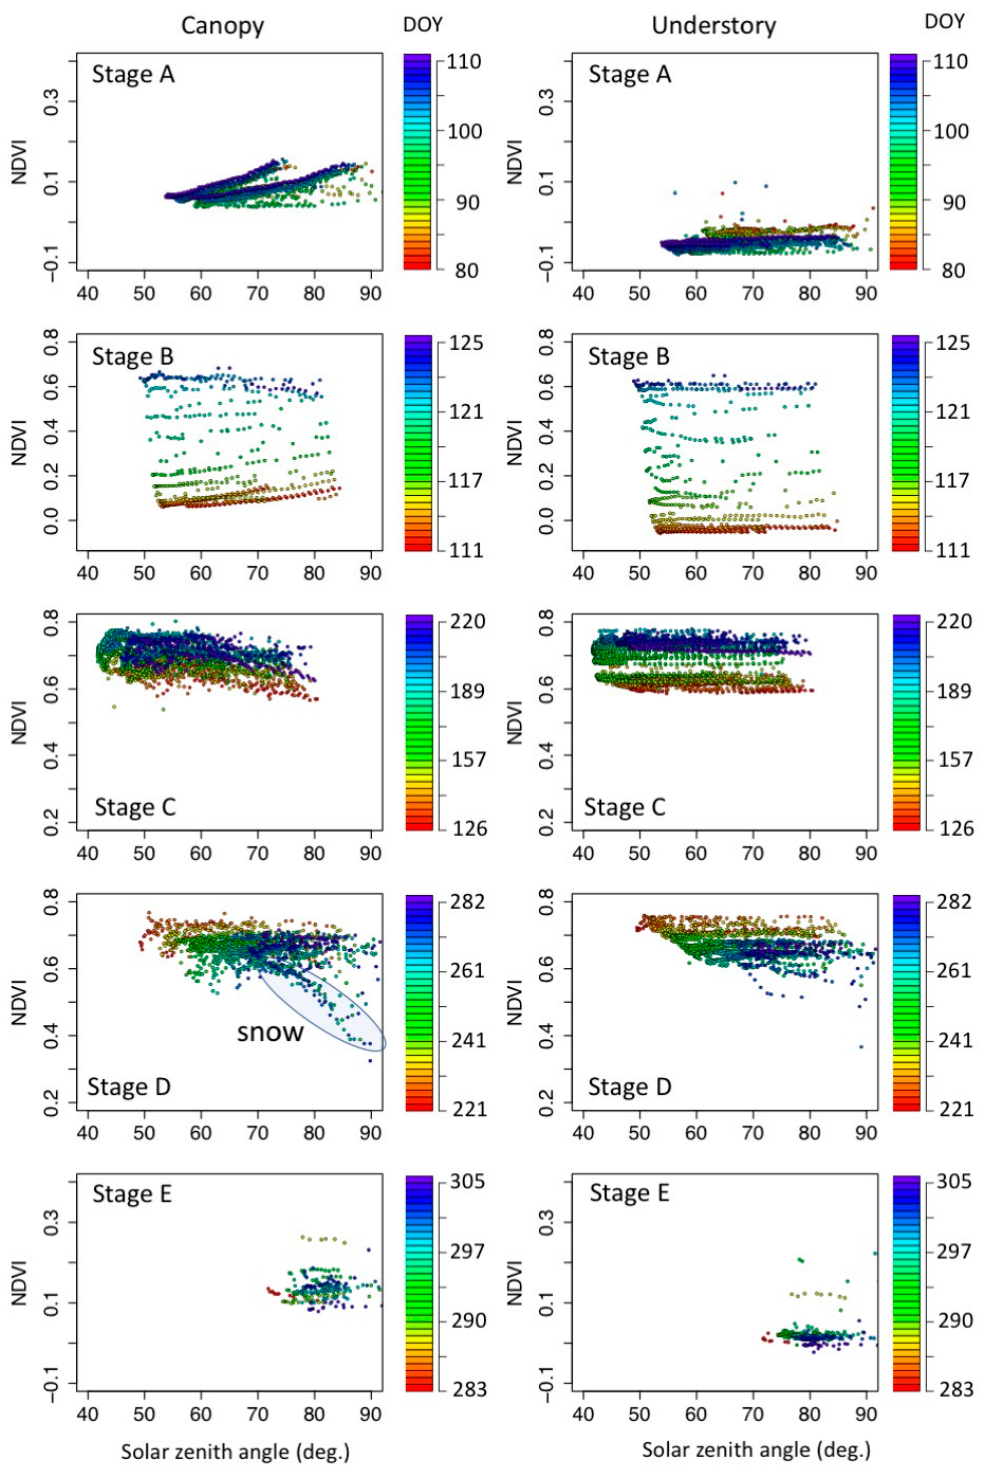
Figure 3. Solar zenith angle dependency of NDVI in five phenological stages. The definition of phenological stages are shown in Figure 2. Left : Canopy scale NDVI (measured at the top of the tower). Right : Understory measurements. Colors on the plotted circles denote the day of the year (DOY) of the measurements.